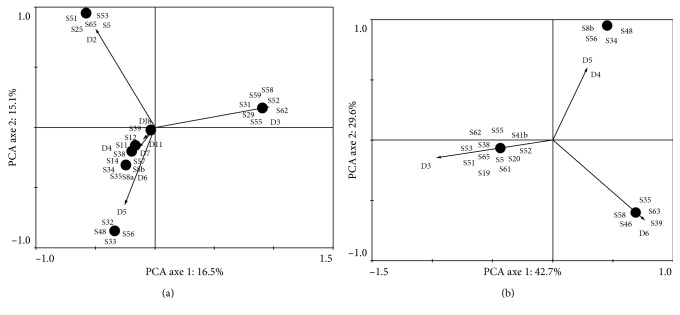
PCA of bacteria showing abilities to grow in Bushnell-Haas (BH) mineral salts medium composed of 10 g/L NaCl, 0.29 g/L KCl, 0.42 g/L MgSO4·7H2O, 0.83 g/L KH2PO4, 0.42 g/L NH4SO4, and 1.25 g/L K2HPO4 and supplemented with gasoline (a) and diesel fuel (b). D2, D3, D4, D5, D6, D7, D8, and D11: growth after 2, 3, 4, 5, 6, 7, 8, and 11 days.